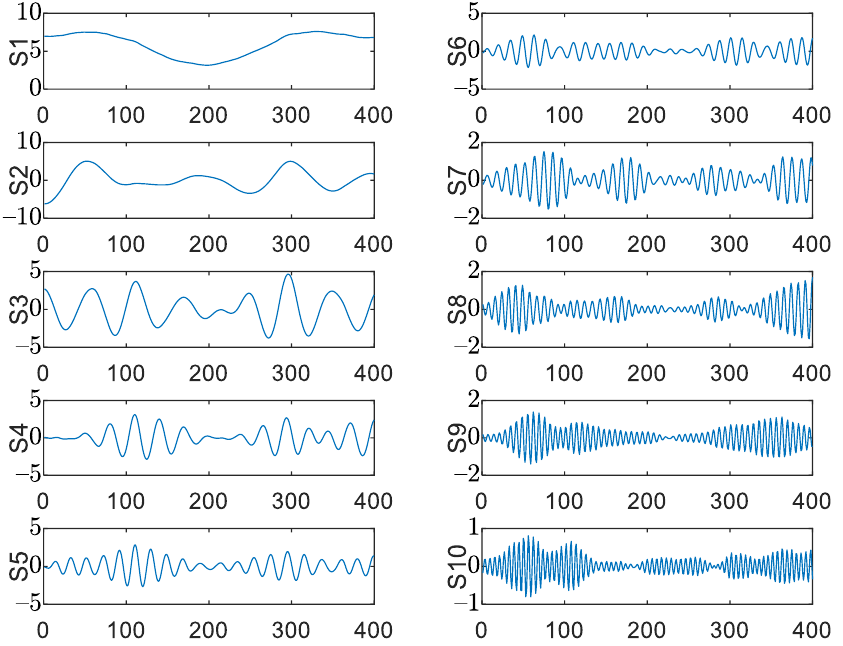
Figure 9. Subseries decomposed by using VMD (S1 –